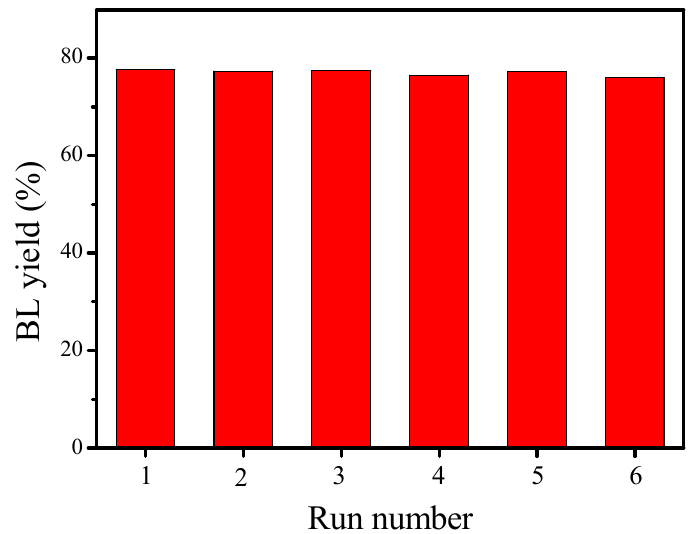
Figure 10. The reusability results of the TiO 2 NPs.